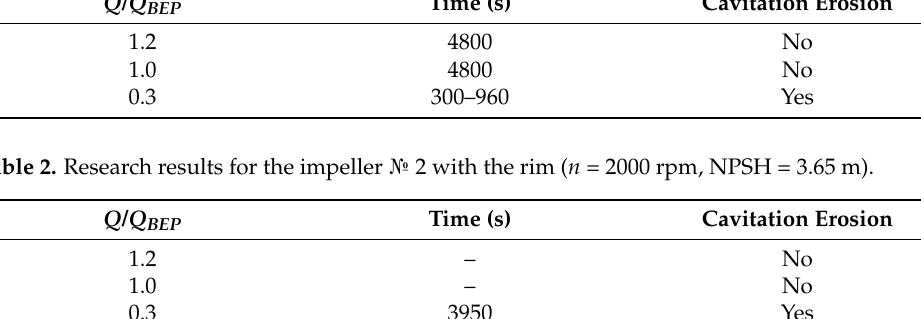
Table 1. Research results for the rimless impeller № 2 ( n = 2000 rpm, NPSH = 3.65 m). Q / Q BEP Time (s)